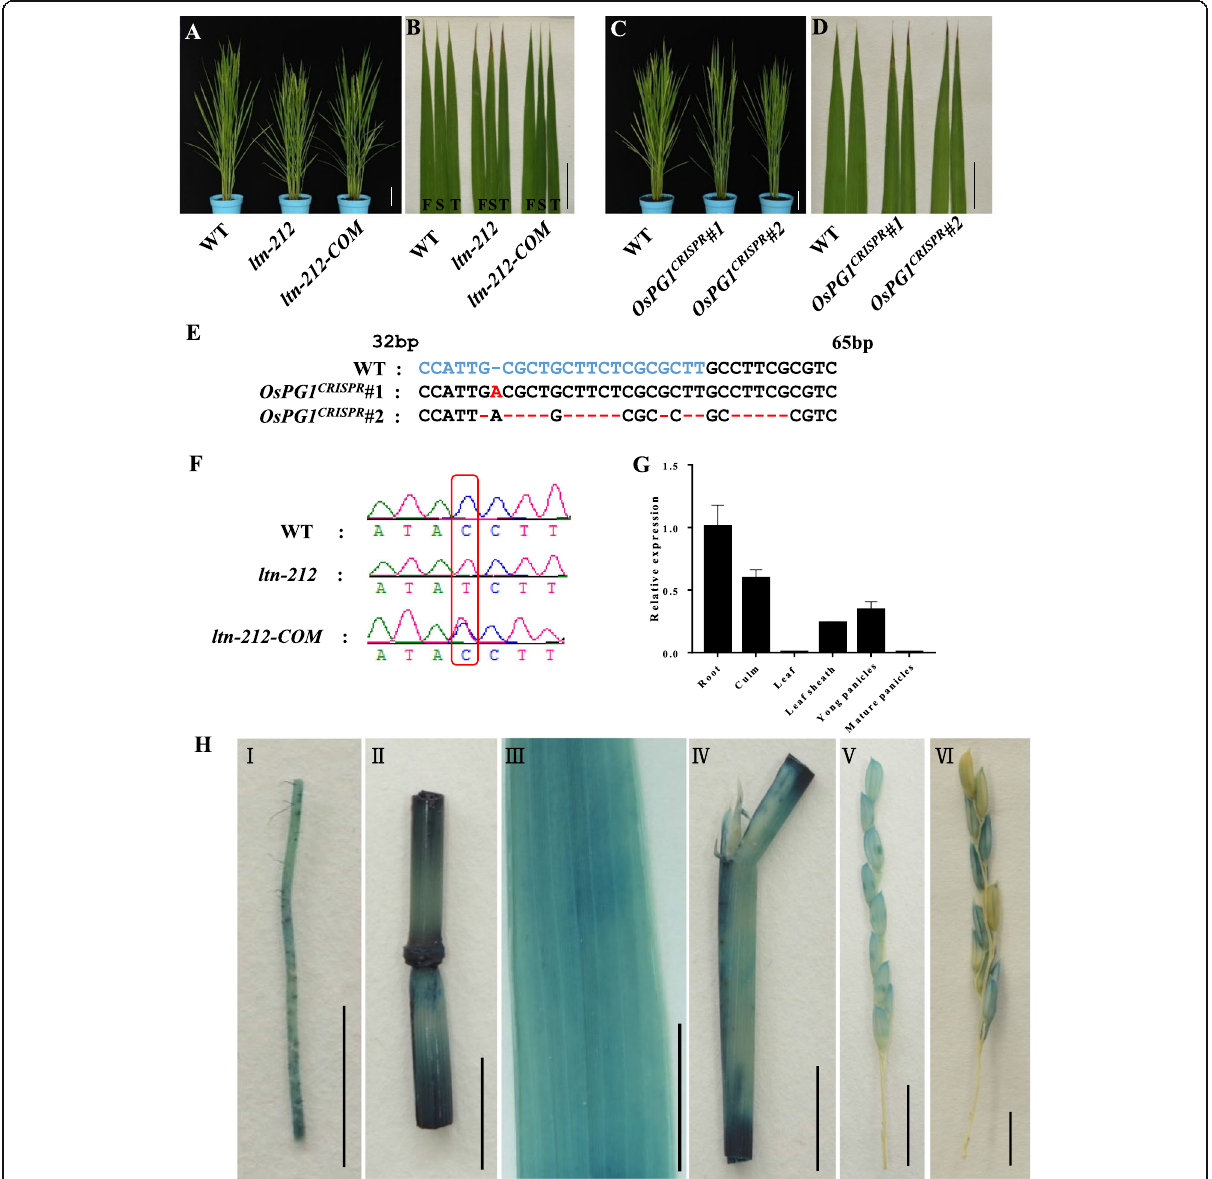
Fig. 5 Genetic complementation, knock-out and expression analysis of OsPG1 . a Phenotype of WT, ltn-212 and T 1 complementation plant (scale bar = 10 cm). b Leaf tip necrosis disappear on the leaves of T 1 complementation plant (scale bar = 5 cm). c Phenotype of WT, and OsPG1 knock- out individuals ( OsPG1 CRISPR #1 , OsPG1 CRISPR #2 ) at JiaHe212 background (scale bar = 10 cm). d Leaf tip necrosis on the leaves of knock-out individuals ( OsPG1 CRISPR #1 , OsPG1 CRISPR #2 ) (scale bar = 5 cm). e Mutational sites of knock-out individuals ( OsPG1 CRISPR #1 , OsPG1 CRISPR #2 ). The blue color words indicate target sequence and the red color words indicate insertion and deletion mutations. f The T 1 transgenic plants were verified by sequencing of the mutation site. g Expression levels of OsPG1 in various tissues (n = 3). h Gus staining of OsPG1 promoter – GUS reporter transgenic plants (scale bar = 1 cm). I: Roots. II:Colum. III: leaf. IV: Sheath. V: Young spikelet. VI: Mature spikelet. Data are means ± SD. ** indicates significance at P ≤ 0.01 and * indicates significance at P ≤ 0.05 (Student ’ s t